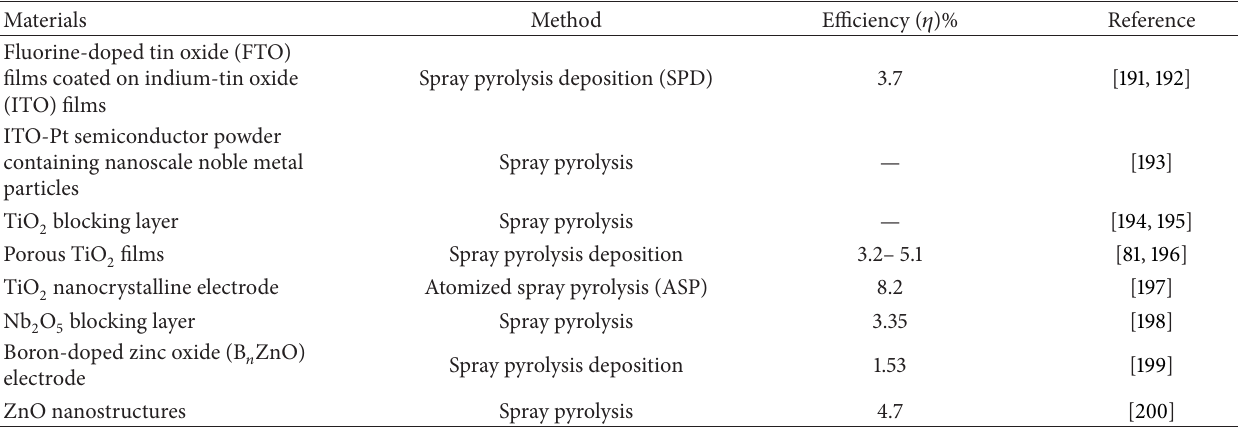
Figure 10: Schematic representation of spray pyrolysis method [18]. Table 5: SPD methods in preparation of